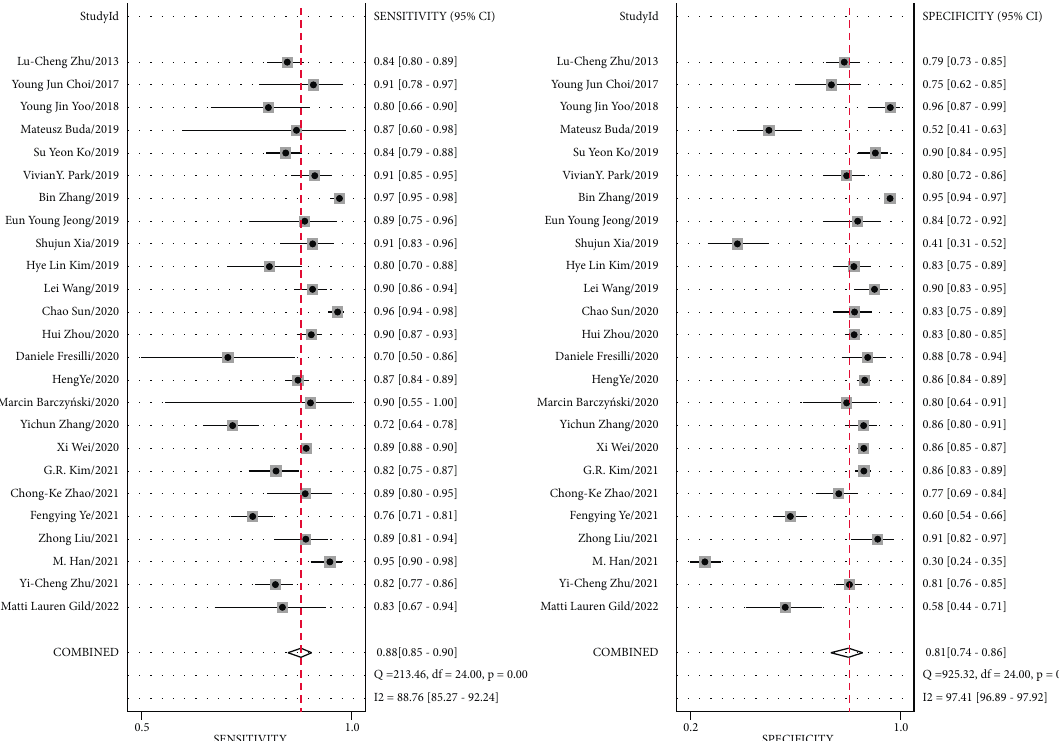
Figure 5: Forest plot of the comprehensive sensitivity and specificity of AI-aided diagnostic techniques for diagnosing